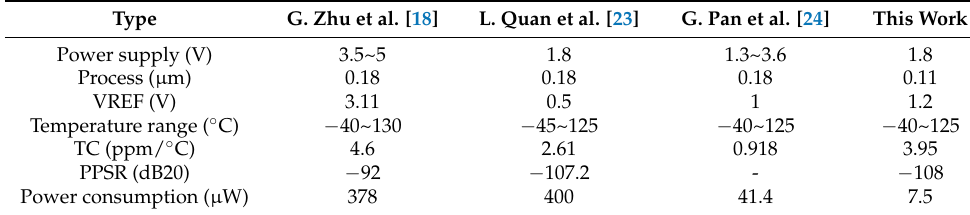
Table 2. Performance